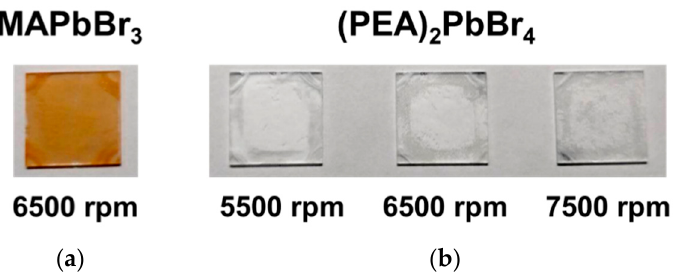
Figure 2. 3D and 2D perovskites sensing samples. ( a ) 3D MAPbBr 3 , ( b ) 2D (PEA) 2 PbBr 4 with different spin speeds.